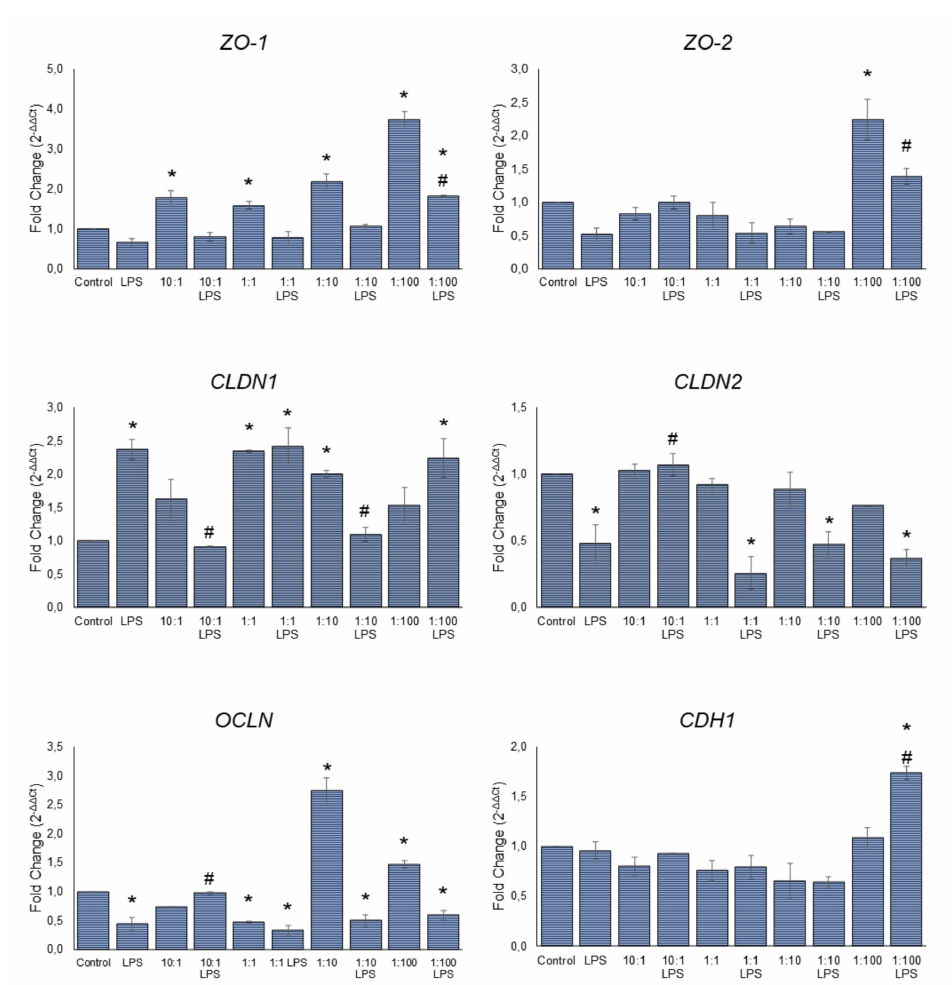
Figure 3. mRNA levels for ZO-1 , ZO-2 , CLDN1 , CLDN2 , OCLN , and CDH1 genes in the Caco-2 cell monolayer. Caco-2 cells were challenged using four different cell/colony-forming unit (CFU) ratios (i.e., 10:1, 1:1, 1:10, and 1:100) for 24 h, in the absence of or in combination with an